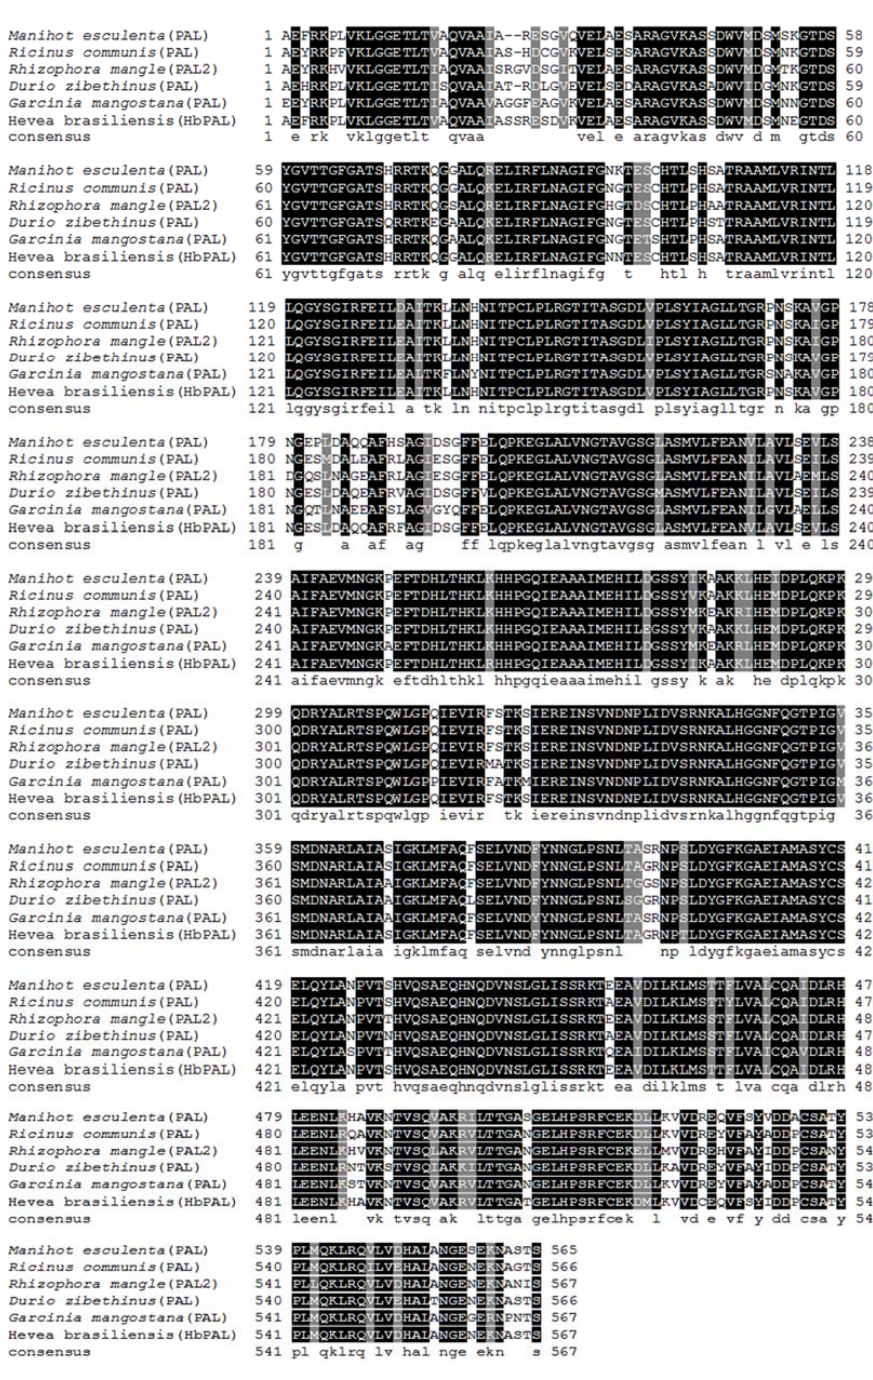
Figure 7. Multiple alignment of the deduced amino acid sequences of HbPAL with phenylalanine ammonia lyase from various plants, M. esculenta (XP_021620397.1), R. communis (XP_002519521.1), R. mangle (AAW51923.2), D. zibethinus (XP_022744606.1) and G. mangostana (ACM62741.1). The conserved amino acid residues are shaded dark and the highly conserved amino residues are shaded grey.